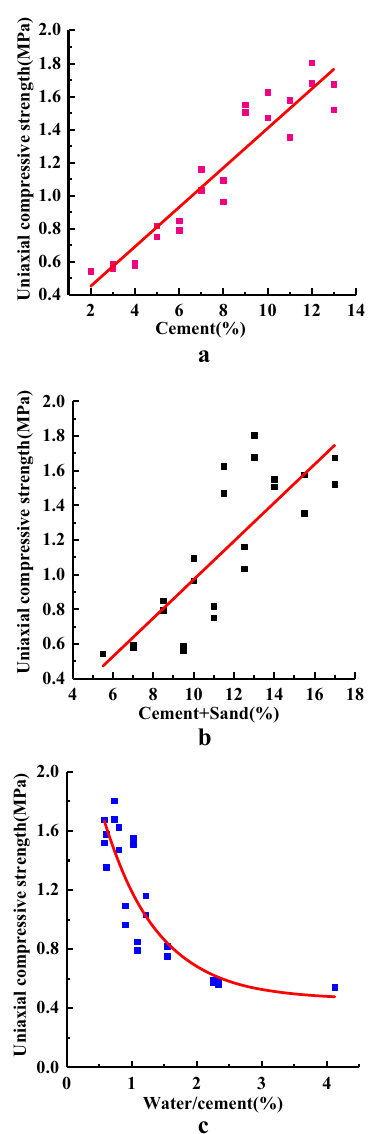
Fig. 7 Effect of cement, sand and water content on uniaxial compressive